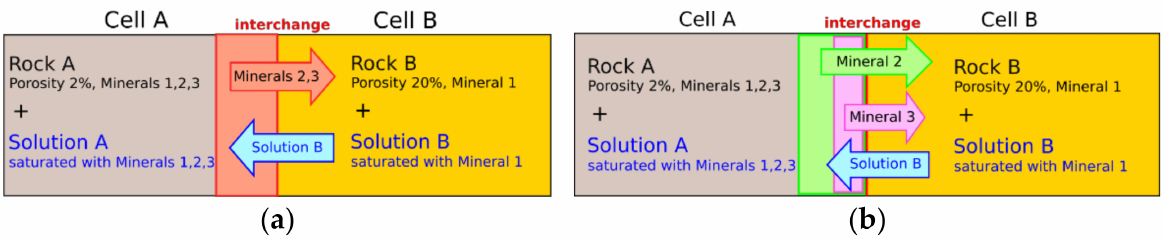
Figure 2. Sketch of the interchange approach with ( a ) constant and ( b ) variable dissolution rates. A defined amount of each mineral according to Equation (2) is dissolved from a cell with low porosity (Cell A) into an adjacent cell with higher porosity (Cell B). These amounts are cumulated, and the solution is transferred into the cell with lower porosity to fill the newly formed pore space (modified from Steding et al.